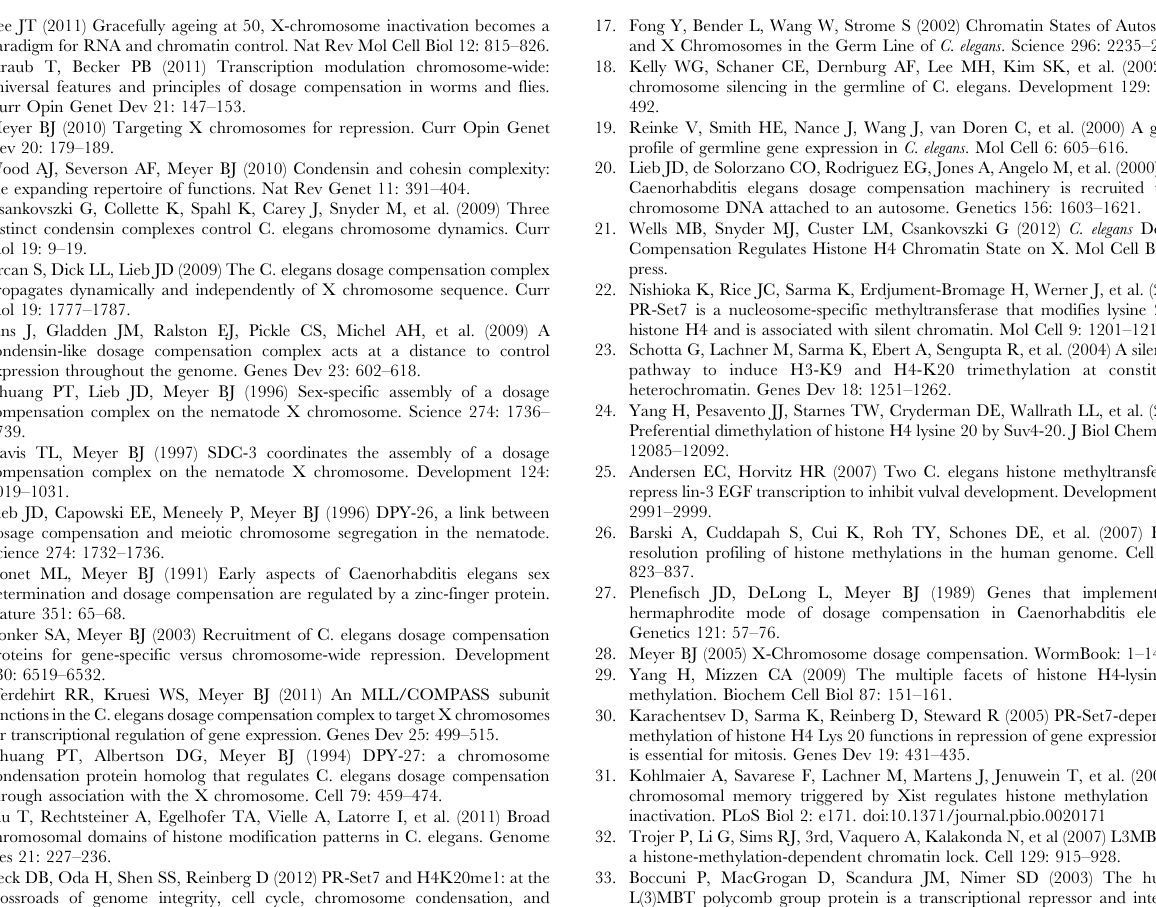
(light shades) are plotted separately. Plots generated using data from the two antibodies show similar patterns. Table S1 ChIP dataset accession numbers. modENCODE or GEO accession numbers for datasets generated or used in the paper. modENCODE data can be obtained from http://data. modencode.org/ or modMine: